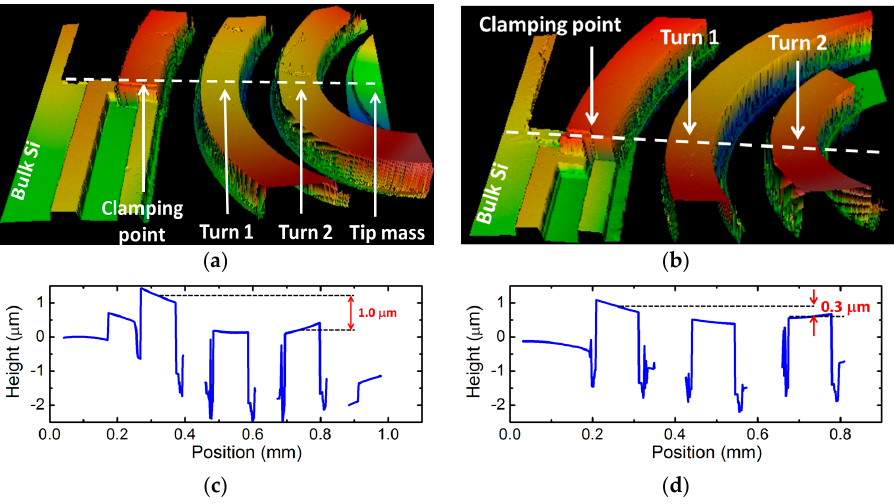
Figure 5. 3D optical surface profiler images taken on a portion of a suspended spiral with ( a ) and without ( b ) seismic mass at its end. Characteristic height profiles along the dashed lines for cantilever with ( c ) and without seismic mass ( d ).